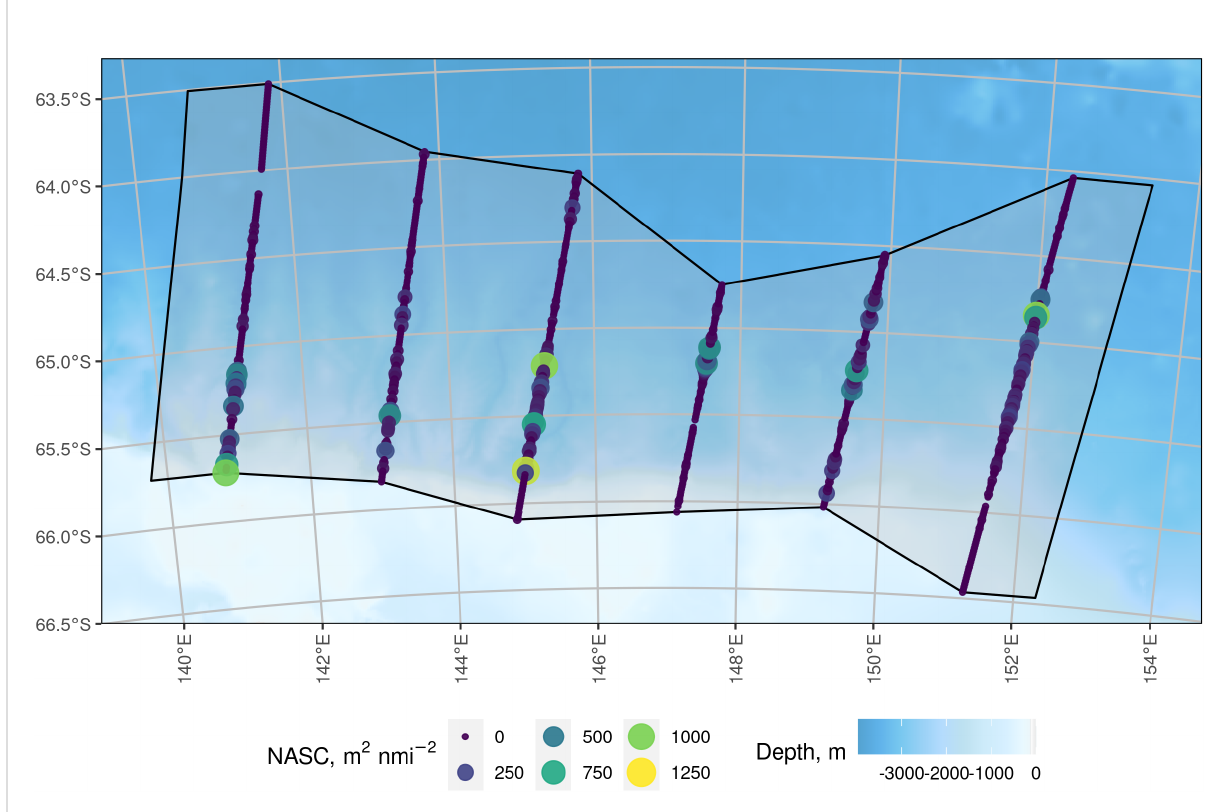
FIGURE 2 Six parallel transects of acoustic data (coloured circles) within the survey domain (grey shaded with the polygon bounded by a solid black line). The transects ranged in length from 150 km to 270 km. Each circle represents the centre of one nautical mile of 120 kHz acoustic data of krill and the size of the acoustic observation circle is proportional to its Nautical Area Scattering Coef fi cient value. The survey boundary joins the northern and southern points of each transect and is expanded by half the inter-transect distance (50 km) to the east and west. Background bathymetry is from the General Bathymetric Chart of the Oceans (GEBCO; The GEBCO_2014 Grid, version 20150318,